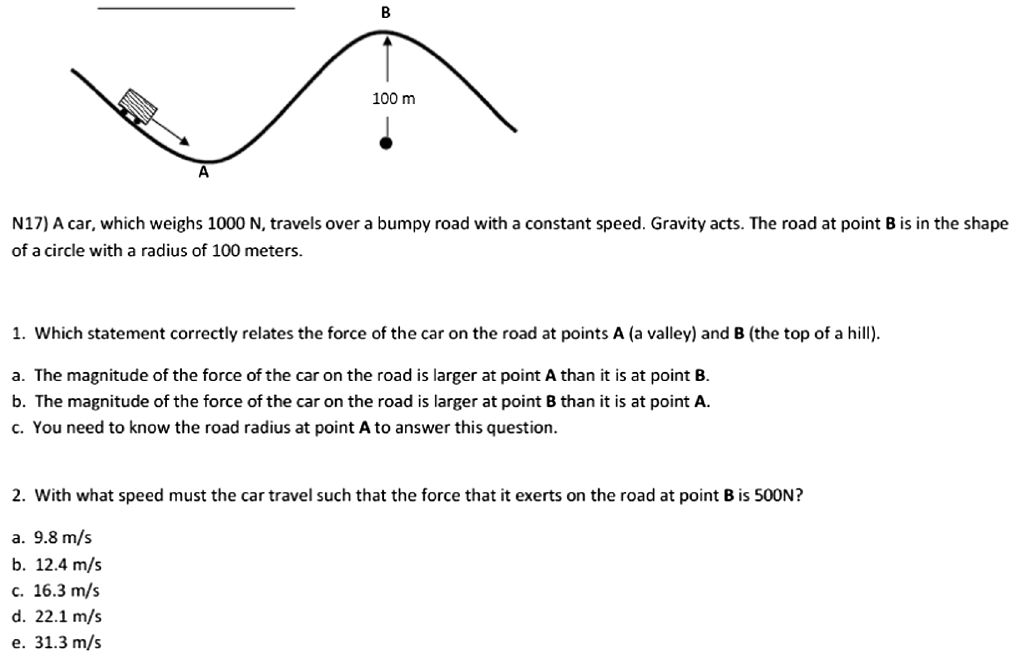
FIG. 2. Example problem